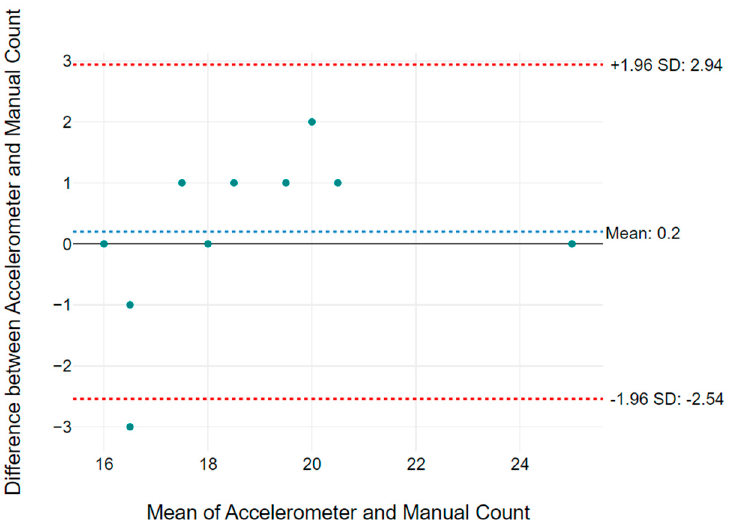
Figure 18. Bland Altman plot based on accelerometer vs. manually counted RR values listed in Table 2.